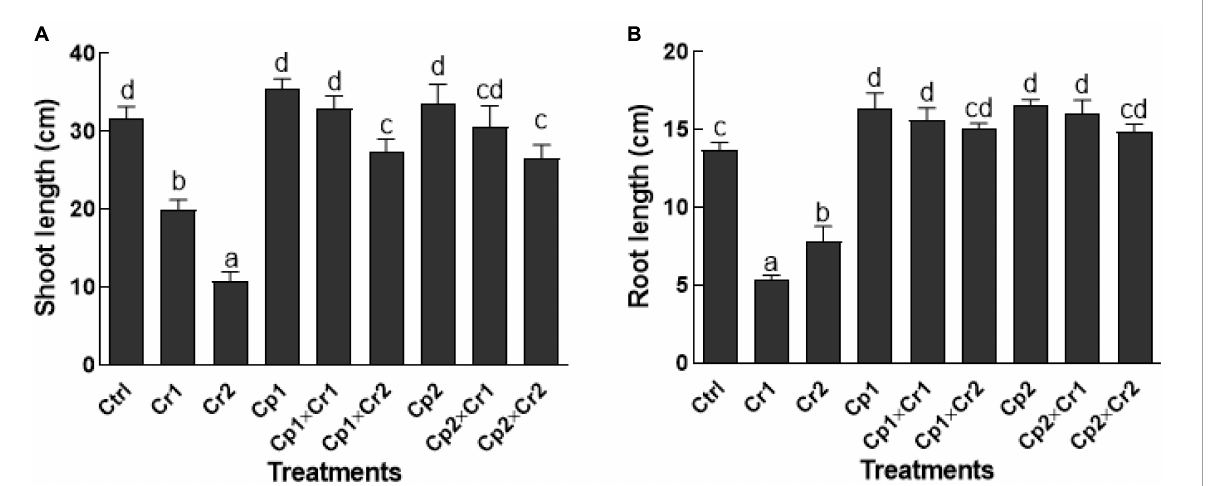
FIGURE1 (A) Shoot and (B) Root length of 15-days-old soybean plants after treatment with selected endophytic fungi exposed to chromate stress. Cp1 = Stemphylium lycopersici ; Cp2 = Stemphylium solani ; Ctrl = control; Cr1 = 10 ppm chromium; Cr2 = 50 ppm chromium. Each bar represents mean of triplicated data ( n = 3) with standard error. Bars that are labeled with different letters are significantly different at p < 0.05 computed by Duncan multiple range